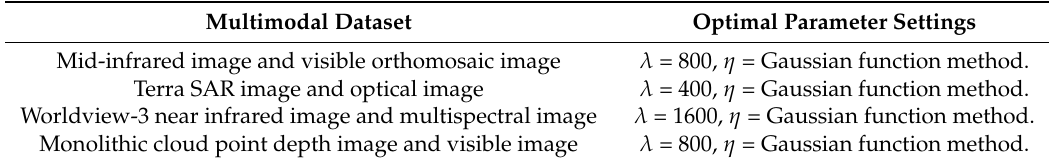
Table 2. The optimal parameter settings for four multimodal datasets. Multimodal Dataset Optimal Parameter Settings Mid-infrared image and visible orthomosaic image λ = 800, η = Gaussian function method. Terra SAR image and optical image λ = 400, η = Gaussian function method. Worldview-3 near infrared image and multispectral image λ = 1600, η = Gaussian function method. Monolithic cloud point depth image and visible image λ = 800, η = Gaussian function